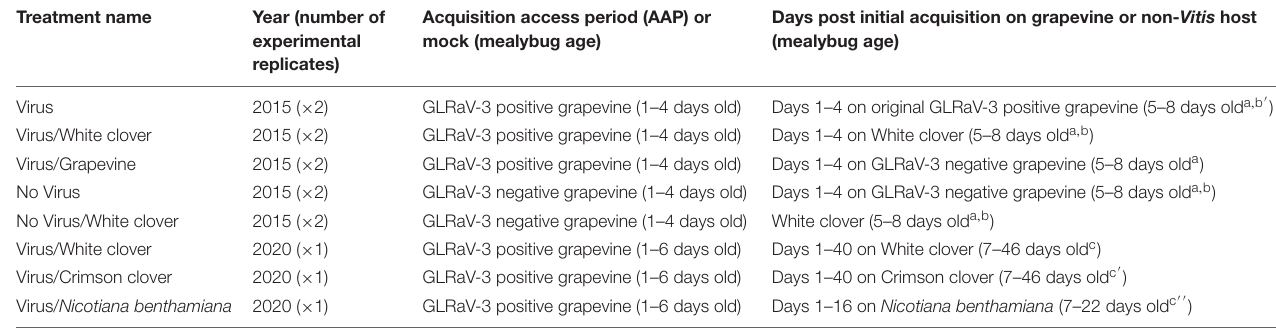
TABLE 1 | Summary of retention experiments performed in 2015 and